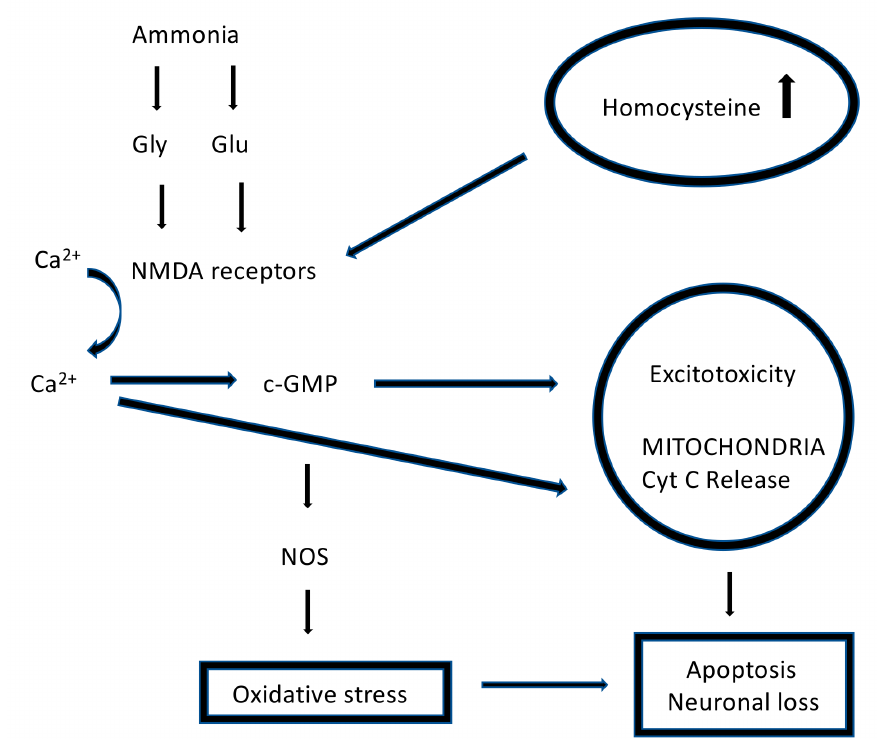
Figure 3. Mechanism of neurotoxicity mediated by Hcy (modified by Choudhury S. et al., Medical Hypotheses Volume 85, Elselvier, Issue 1, 2015; pp. 64–67). Gly: glycine; Glu: glutamate; NMDA receptors: N-methyl-D-aspartate receptors; NOS: nitric oxide